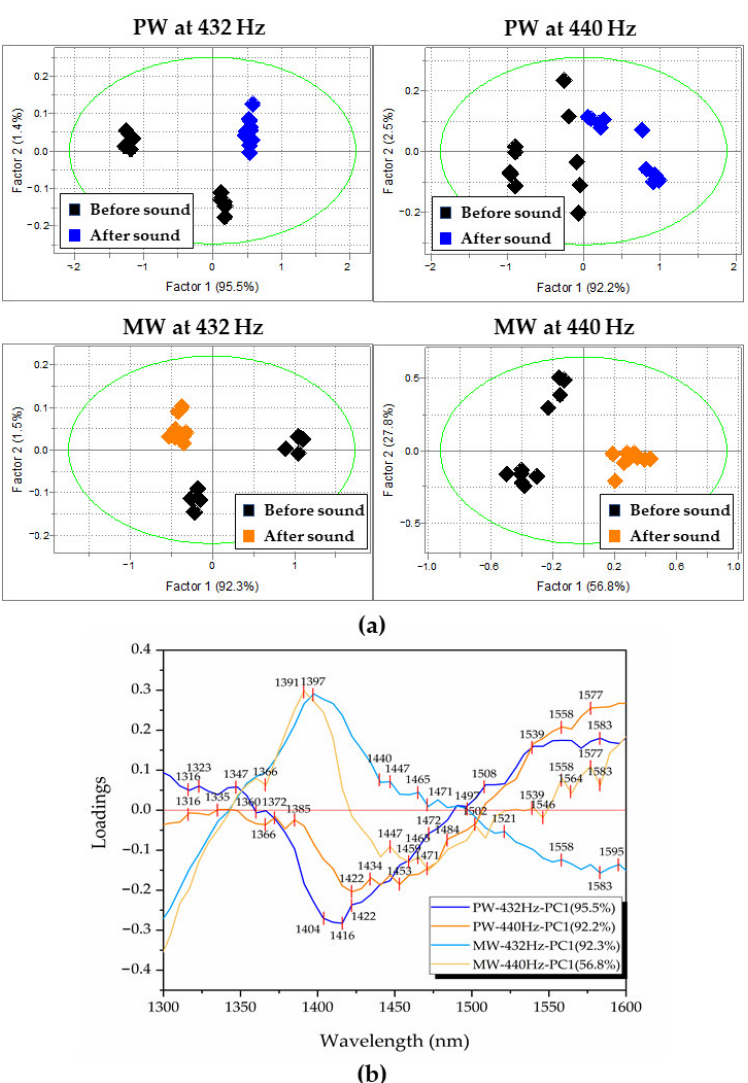
Figure 2. PCA scores and loadings separating samples before and after sound: ( a ) Scores of 1st and 2nd principal components for the 4 datasets; ( b ) loadings of 1st principal components for the 4 datasets, separating before from after samples (it should be noted that the sign of PC loadings is assigned arbitrarily, and due to this, the loading of PC1 for MW at 432 Hz was multiplied by −1).